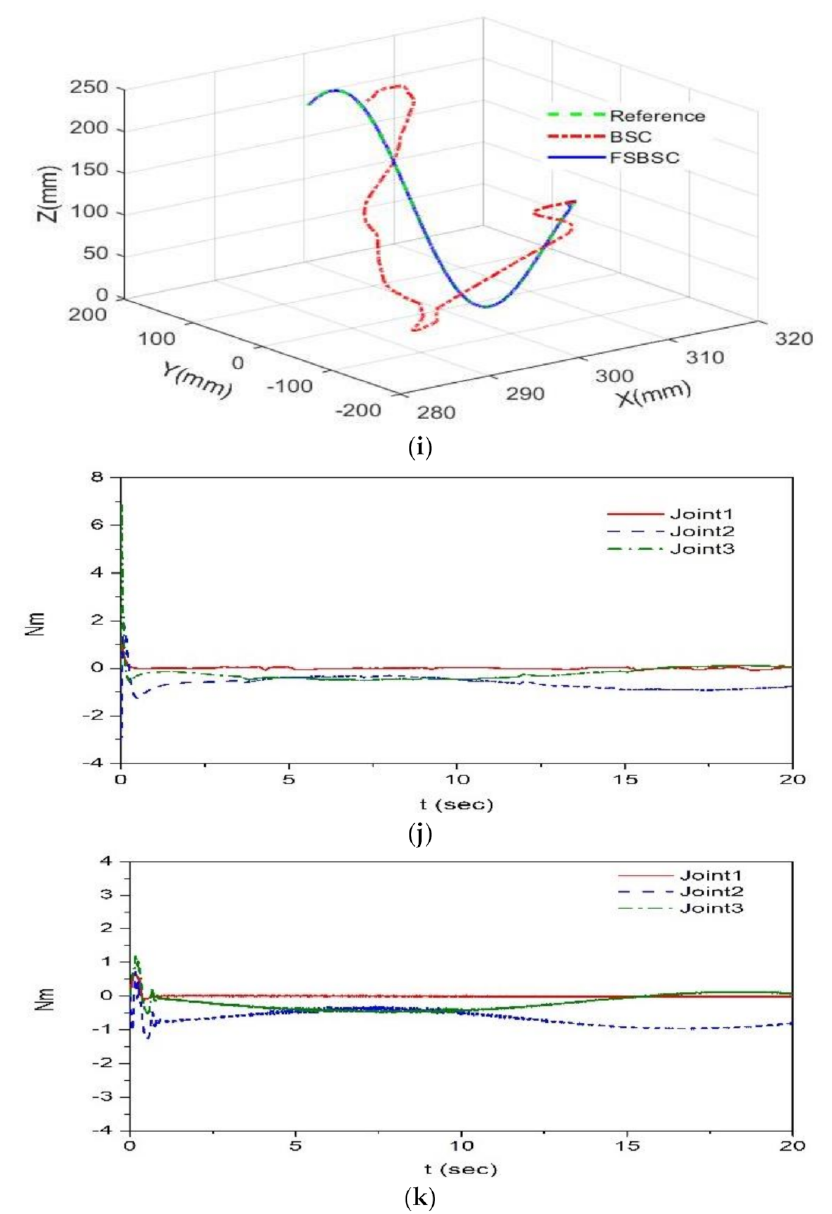
Figure 6. The end effector positioning tracking results. ( a ) Reference positioning command of the end effector in the Cartesian coordinate. ( b ) Reference positioning command of the end effector in the joint coordinate. ( c ) Command tracking output in the joint 1 of the BSC and the FSBSC systems. ( d ) Command tracking error in the joint 1 of the BSC and the FSBSC systems ( e ) Command tracking output in the joint 2 of the BSC and the FSBSC systems. ( f ) Command tracking error in the joint 2 of the BSC and the FSBSC systems. ( g ) Command tracking output in the link 3 the BSC and the FSBSC systems. ( h ) Command tracking error in the link 3 the BSC and the FSBSC systems. ( i ) 3D tracking trajectory of the end effector of the BSC and the FBSC systems. ( j ) Control input of the BSC system. ( k ) Control input of the FSBSC